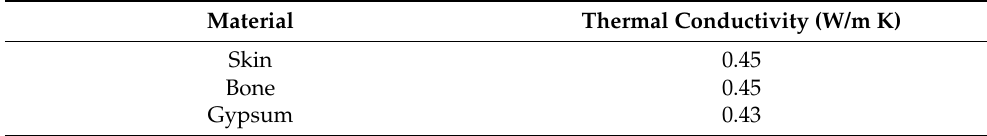
Table 1. Thermal conductivity of different